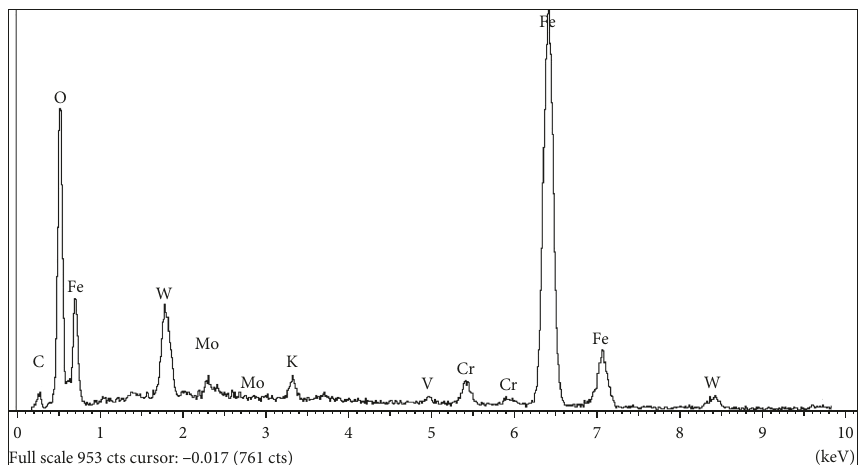
Figure 8: EDS spectrum of the oxides in Figure 7.